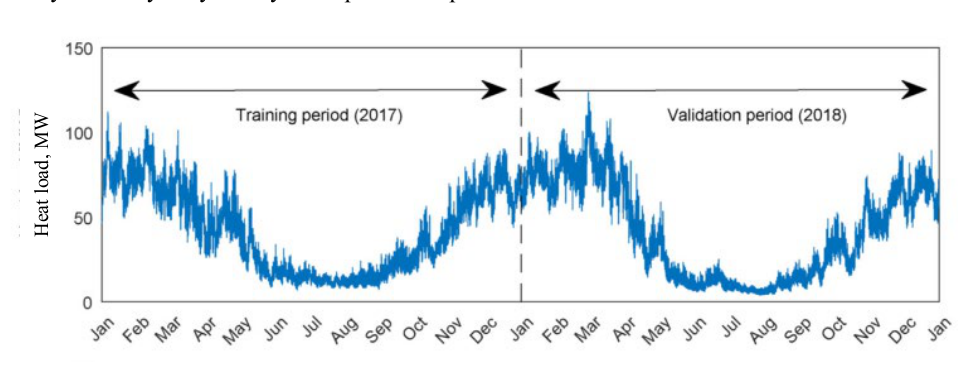
Fig. 5. Monthly time series data of the aggregated heat load of 18 475 single family houses by [41].